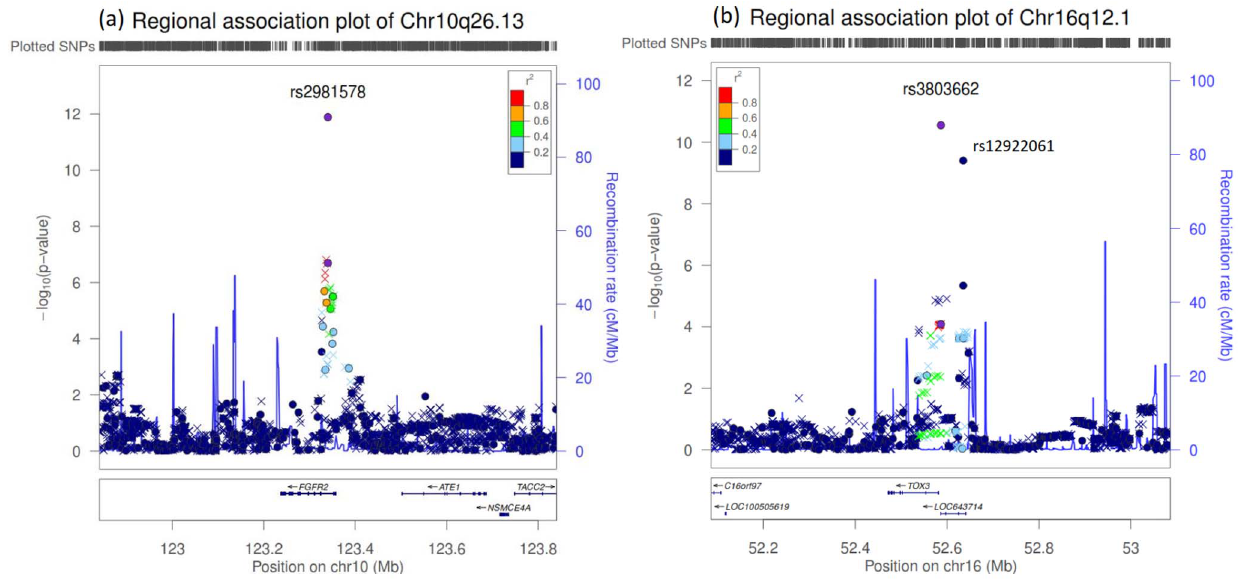
Figure 2. Regional association plots for two significantly associated loci with breast cancer in Japanese population, (a) chromosome 10q26.13 ( FGFR2 ) and (b) chromosome 16q21.1 ( TOX3-LOC643714 ). SNPs from the GWAS are plotted as circles; imputed SNPs are plotted as crosses. The color intensity reflects the extent of LD with the marker SNP: red, (r 2 $ 0.8), orange (0.6 # r 2 # 0.8), green (0.4 # r 2 # 0.6), light blue (0.2 # r 2 # 0.4) and dark blue (r 2 , 0.2). Purplish blue lines represent local recombination rates. The SNP position is based on NCBI build 37.